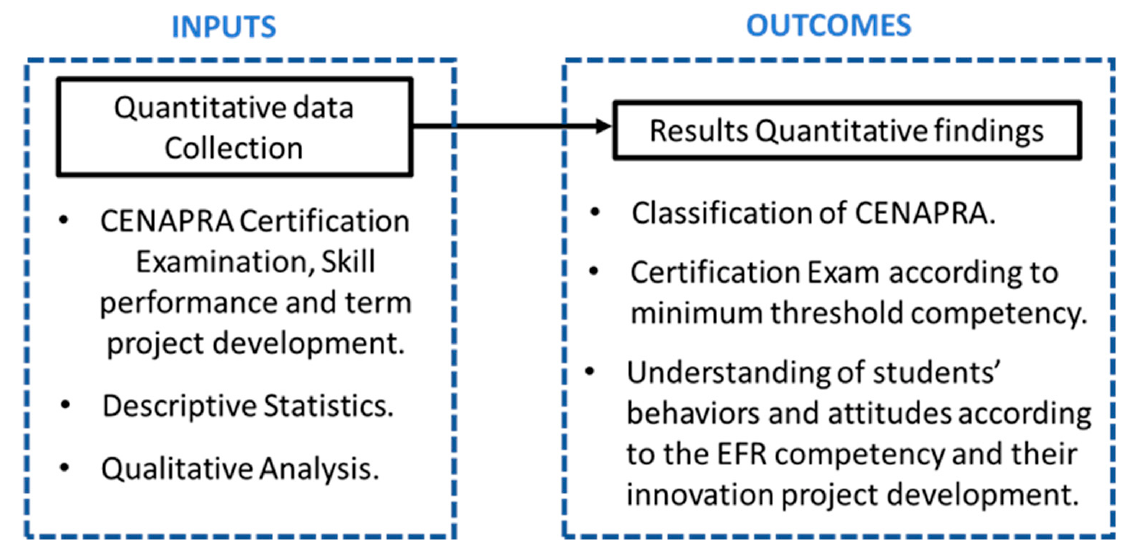
Figure 1. Inputs and outcomes of the sequential quantitative method for the evaluation of the EFR competency.